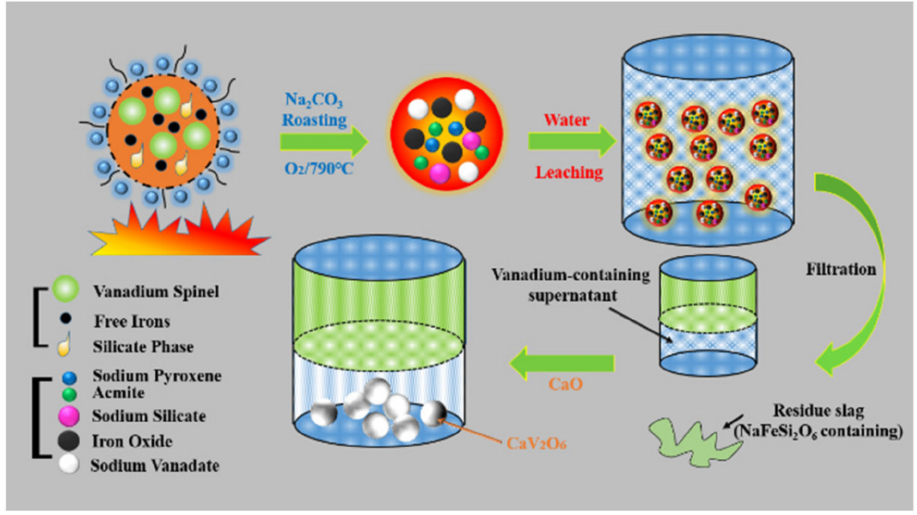
Figure 14. Process